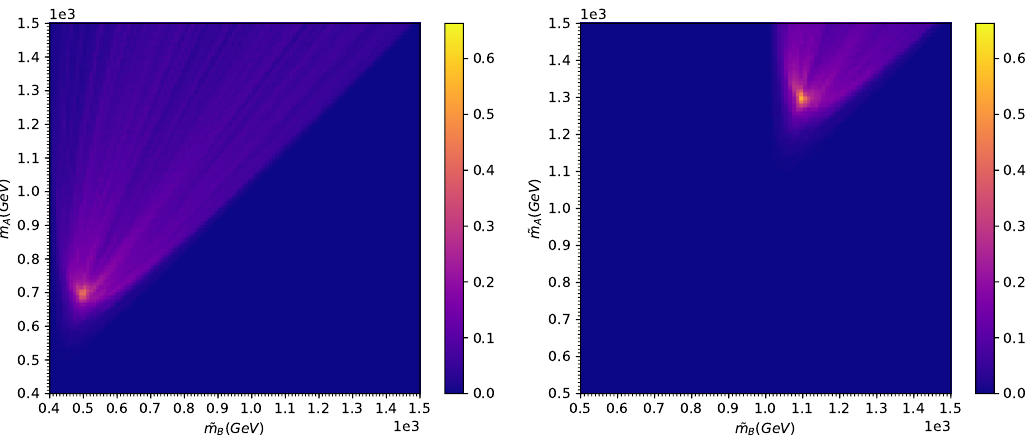
Figure 18 . The same as (cid:12)gure 16, but for ~ m (right panel).